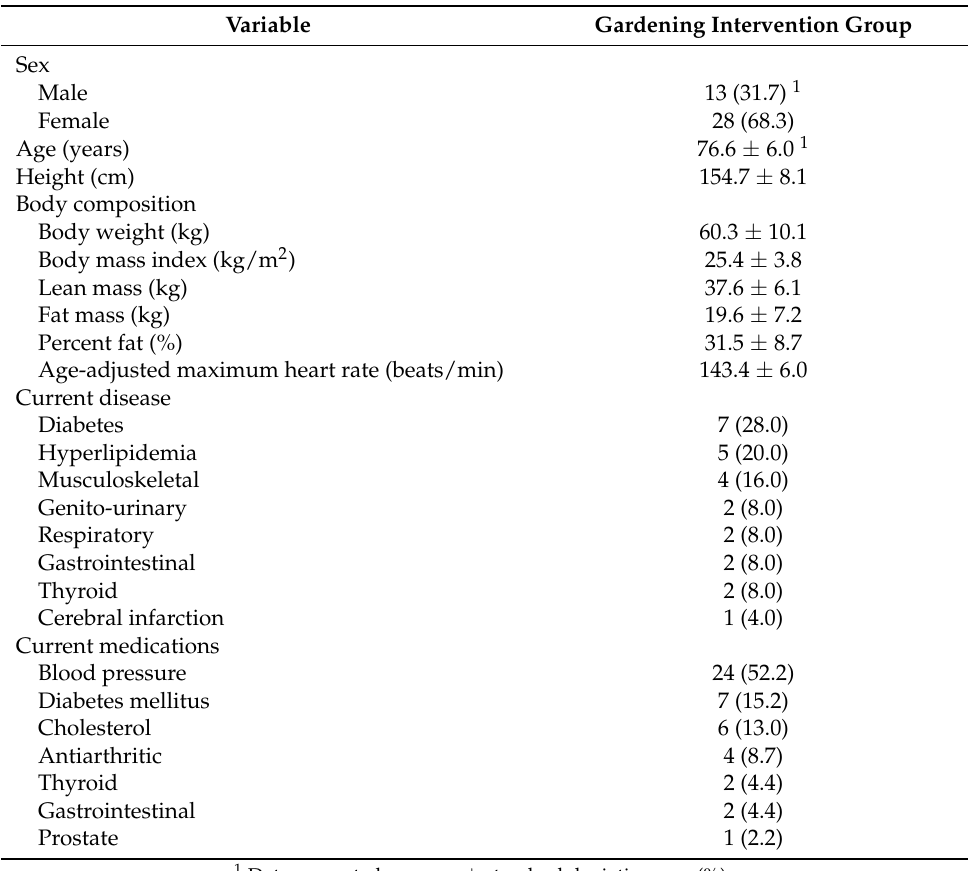
Table 2. Demographic characteristics of the participants ( n = 41).